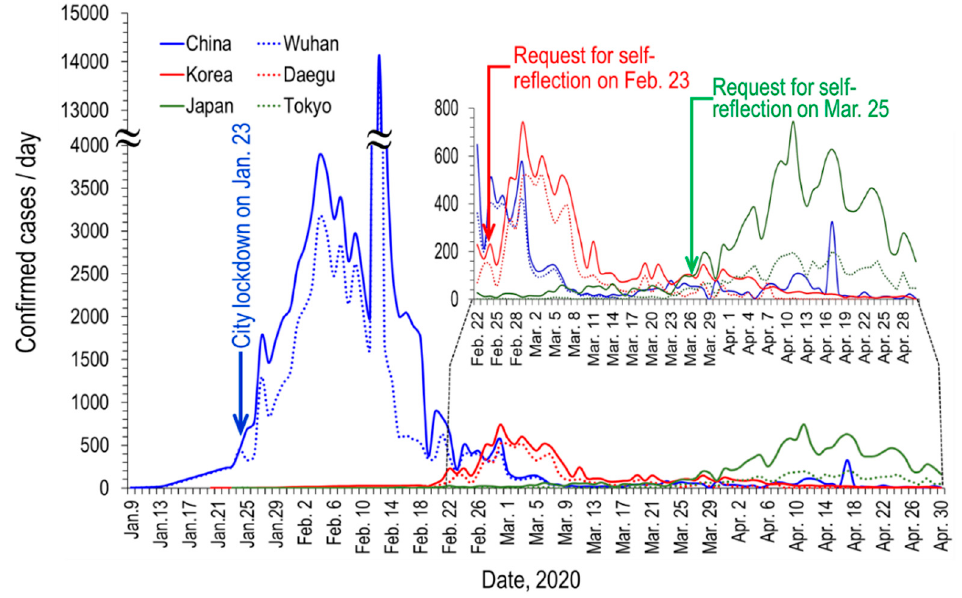
Figure 1. The maps of Wuhan, Daegu, and Tokyo and the locations of air pollution monitoring stations (AQMS) in each city.